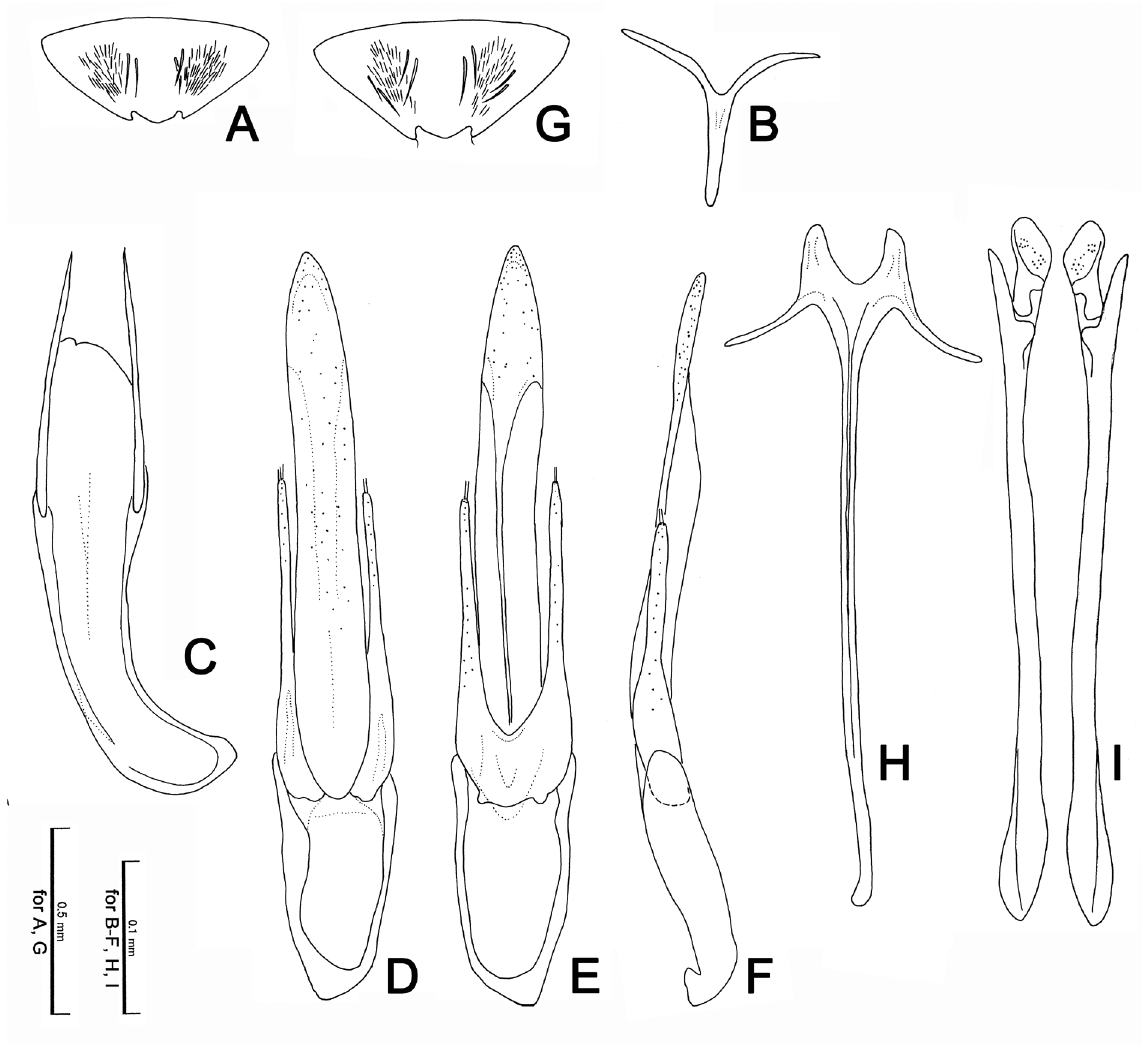
Fig. 14. Mexico papuanus sp. nov., male (A–F) and female (G–I) genitalia (holotype and paratype, BPBM). A, G . Sternite VII. B . Sternite VIII. C . Sternite IX. D . Aedeagus in dorsal view. E . Aedeagus, ventral view. F . Aedeagus, left lateral view. H . Urosternite. I